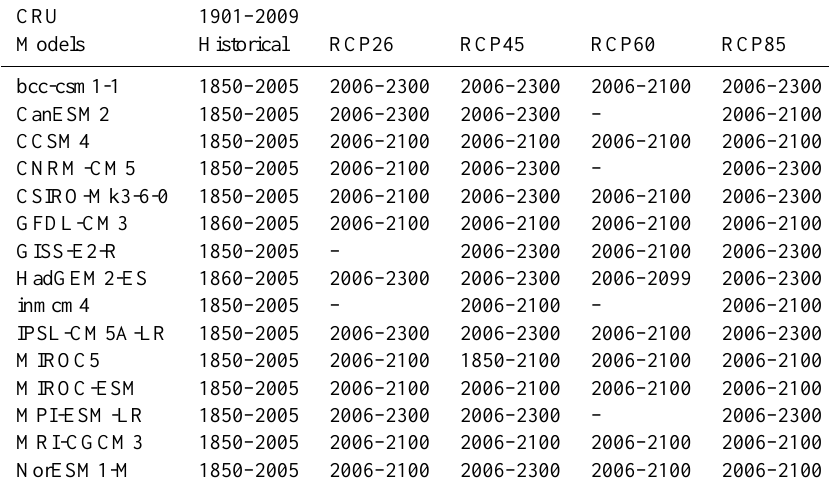
Table 4. Data and models used for forcing.